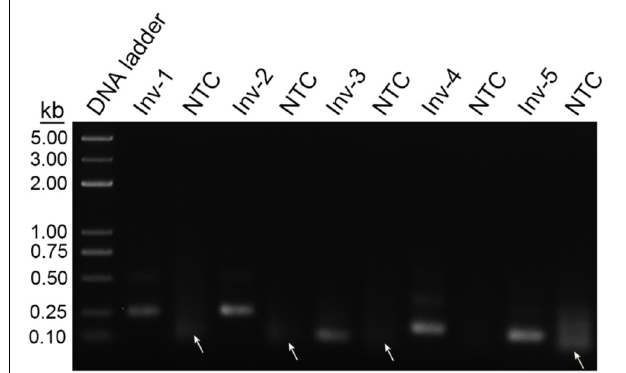
FIGURE 2 | Screening of primer pairs by recombinase polymerase amplification (RPA) amplification performance. The agarose gel image shows the amplification results of the primer pairs targeting virulence genes of InvA and InvE . Each primer pair name is indicated on the top of each lane. The NTC lane immediately after is the no-template control of the respective primer pair. The band sizes of the DNA ladder are shown on the left. Primer dimers are indicated by white arrows.